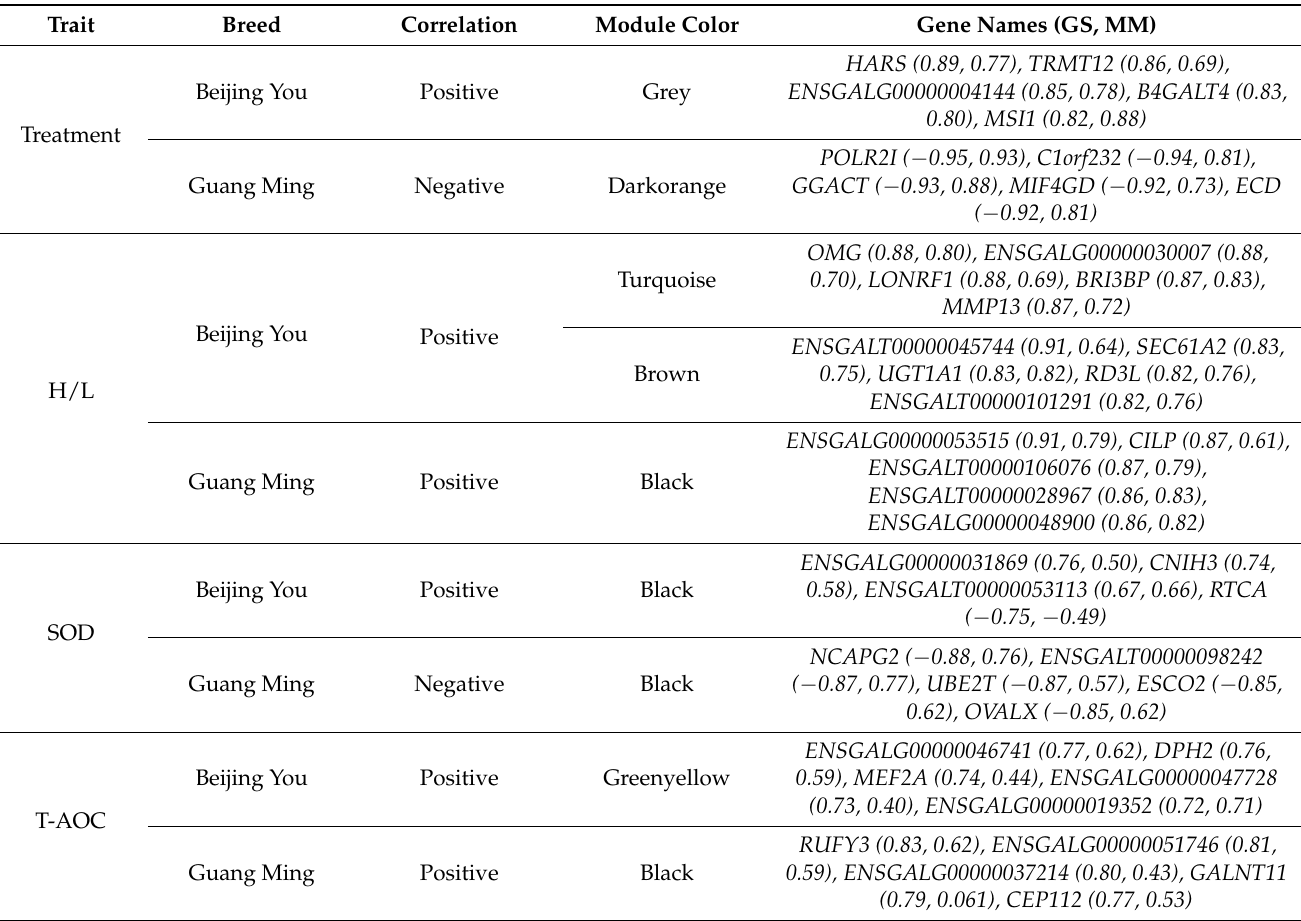
Table 2. Top five driver genes in the significant modules of Beijing You and Guang Ming chickens 5 days post-heat